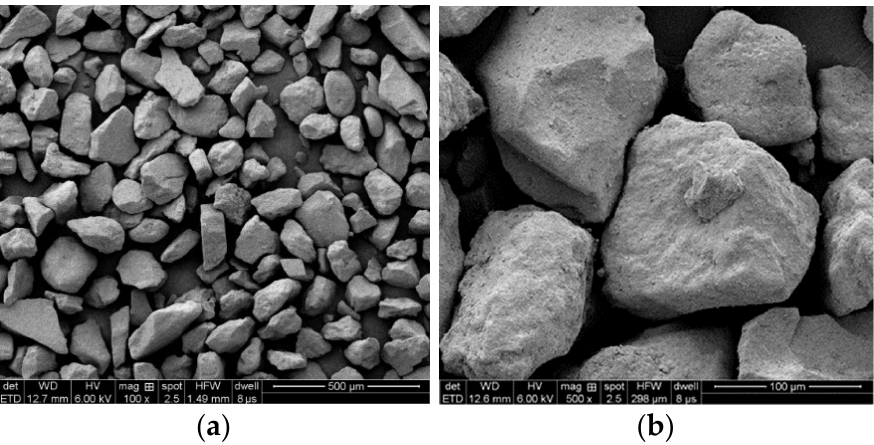
Figure 3. SEM images of aeolian sand. ( a ) SEM image of 100 times; ( b ) SEM image of 500 times.